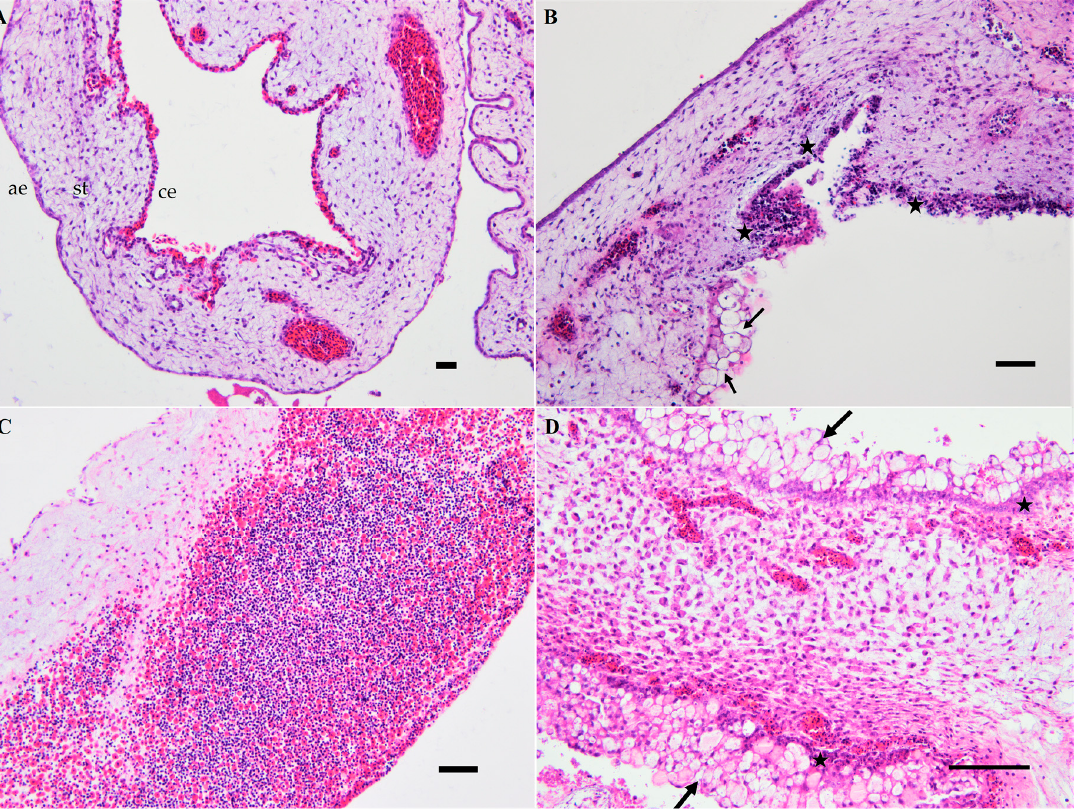
Figure 3. Chorioallantoic membrane from chicken embryos inoculated with the USU-BE-Seraing/2017 strain via the allantoic route. ( A ) Negative control two days after mock inoculation; ( B ) diffuse necrosis in the chorionic layer indicated by cell vacuolization (arrows) and massive nuclear fragmentation (stars) at two days post-infection (dpi); ( C ) massive infiltration of lymphocytes and heterophils in the stroma on day 5 post-infection; ( D ) Severe degeneration with vacuolization (arrows) and necrosis (stars) of cells in both epithelial layers (5 dpi). Abbreviations: ae, allantoic epithelium; ce, chorionic epithelium; st, stroma. Hematoxylin and eosin stain. Scale bars = 50 µm.